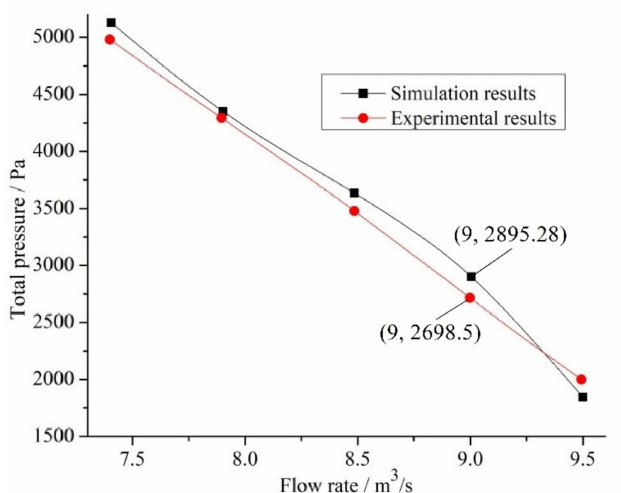
Figure 6. Comparison between the experimental and the simulation results of total pressure of the